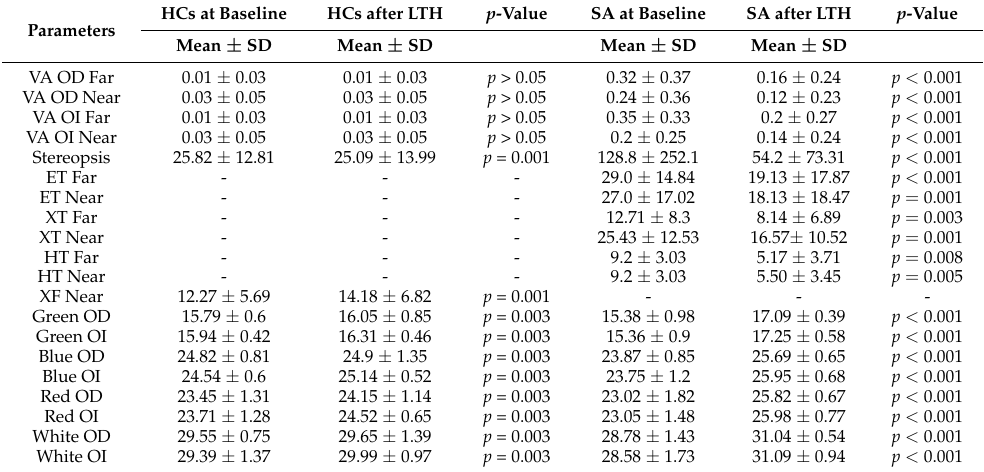
Table 17. Clinical measurements of SA and HC groups, at baseline and after 20 sessions of LTH. HCs at Baseline HCs after LTH p -Value SA at Parameters